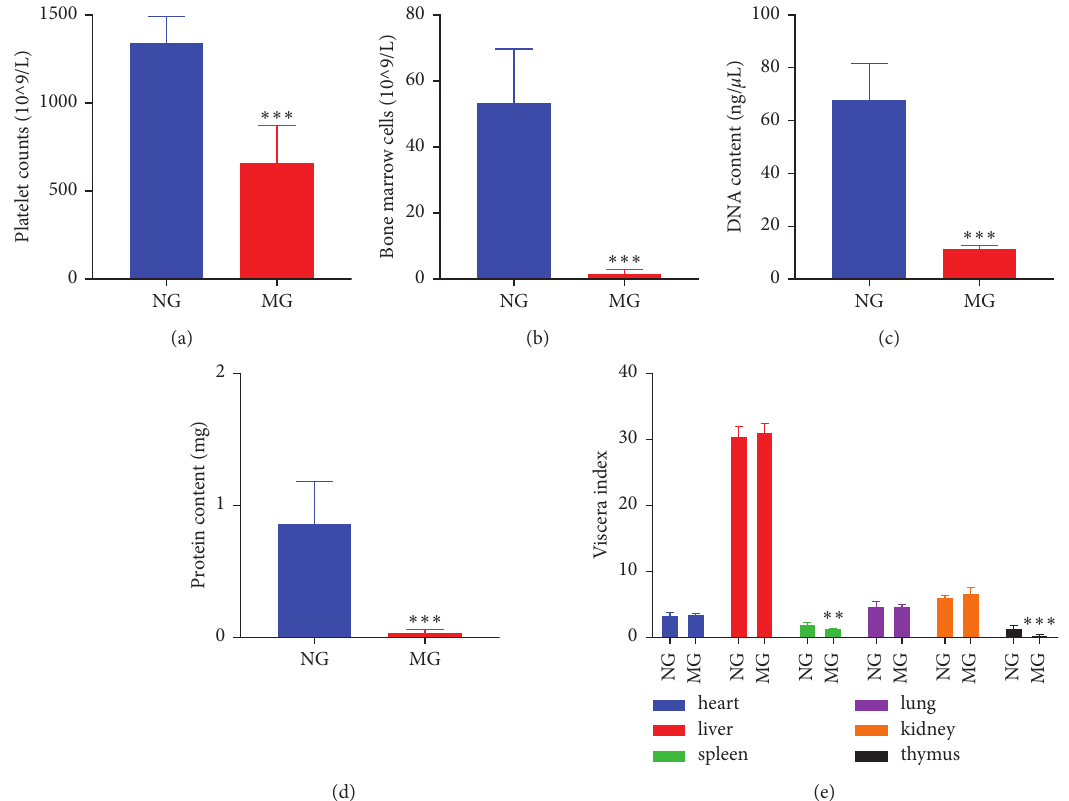
Figure 3: The platelet count (a), bone marrow cell count (b), DNA content (c), protein content (d) and visceral index (e) of the normal and model rats. Normal group and model group are abbreviated to NG and MG, respectively. ∗∗ P < 0 . 01, ∗∗∗ P < 0 . 01 significant compared with NG.